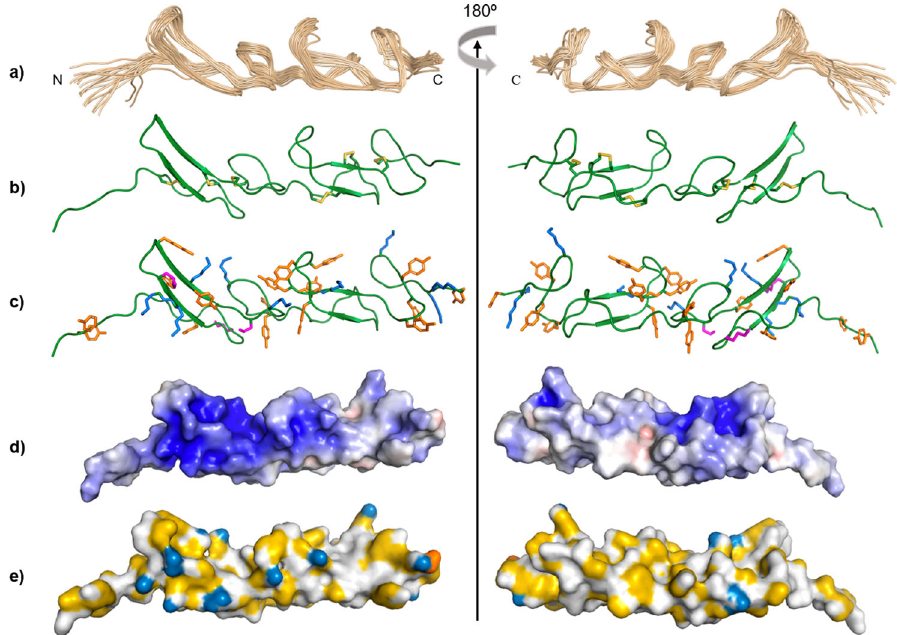
Fig. 2 Solution NMR structure of Pvfp-5 β . a Superimposition of the 20 lowest energy structures. b Cartoon representation of the structure at lowest energy with disul fi de bridges in yellow. c Cartoon representation of the structure at lowest energy with tyrosines, lysines and arginines highlighted in orange, blue and magenta, respectively. d Electrostatic surface potential with acidic residues in red and basics in blues. e Hydrophobic surface.